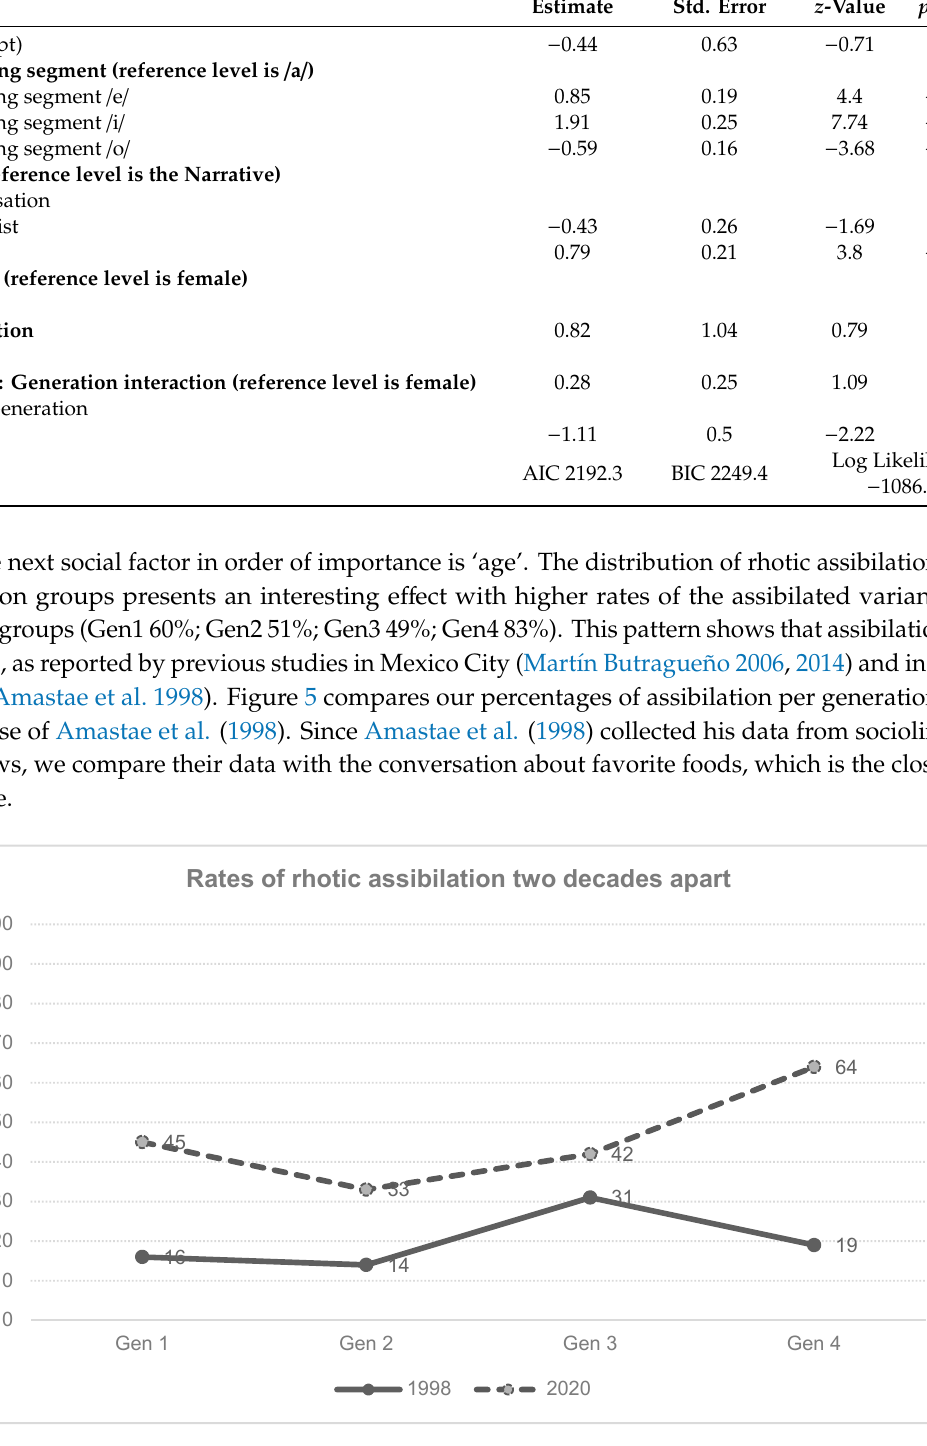
Figure 5. Comparison of the distribution of rhotic assibilation across generation groups in Amastae et al. (1998) and our 2020 data.